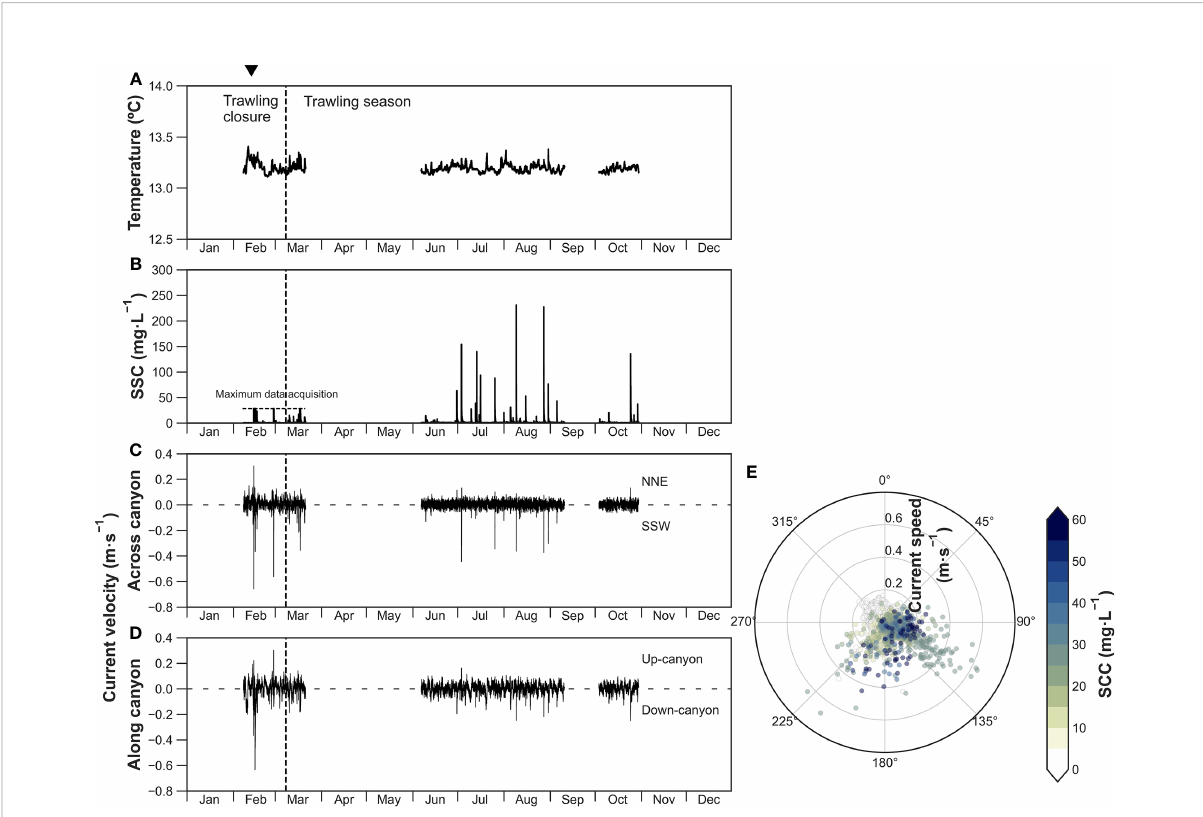
FIGURE 5 Axis-1200 time-series of (A) temperature, (B) suspended sediment concentration (SSC), (C) across-canyon current velocity, and (D) along- canyon current velocity. Note the maximum data acquisition for SSC in the fi rst deployment. (E) Polar plot of non-rotated current direction (angle), current speed (radius) and turbidity (color bar) at 5 mab. The inverted triangle on top indicates the occurrence of a dense shelf water cascading